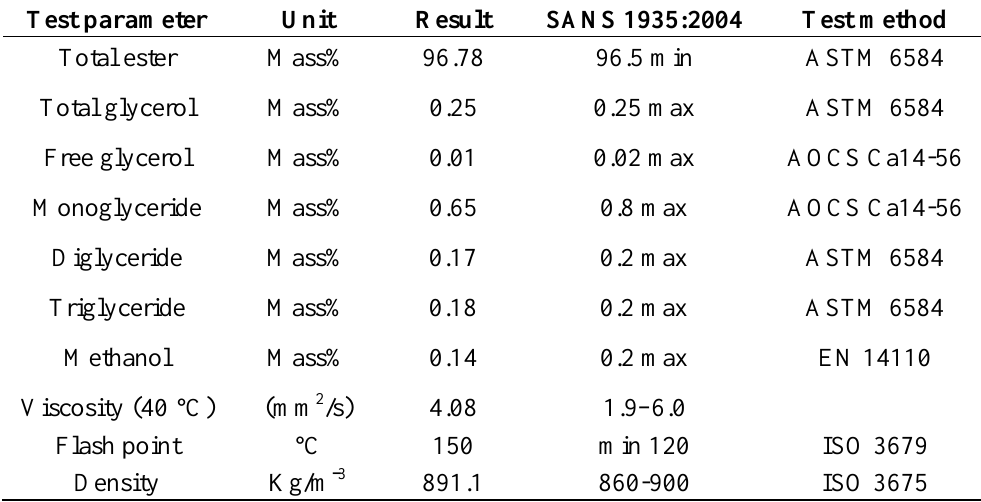
Table 3. Properties of FAME obtained from waste